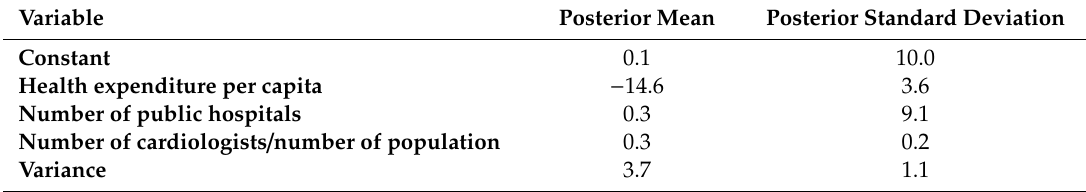
Table 1. The impact of di ff erent factors on the deaths caused by CVDs in Romania (1995–2016). Variable Posterior Mean